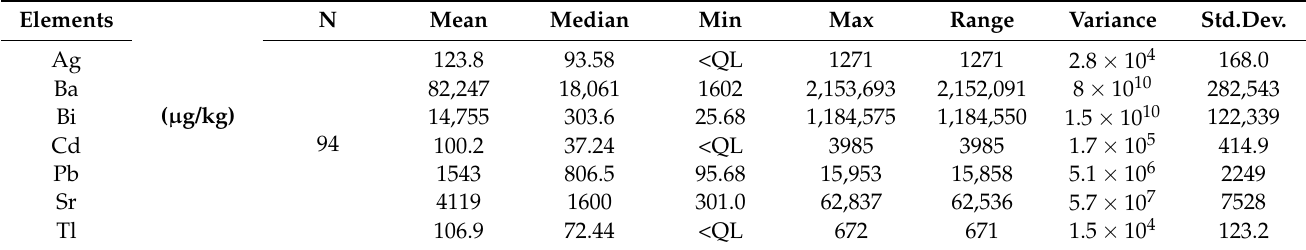
Table 2. The basic descriptive statistics for studied variables in all analyzed eye shadow samples ( µ g/kg).